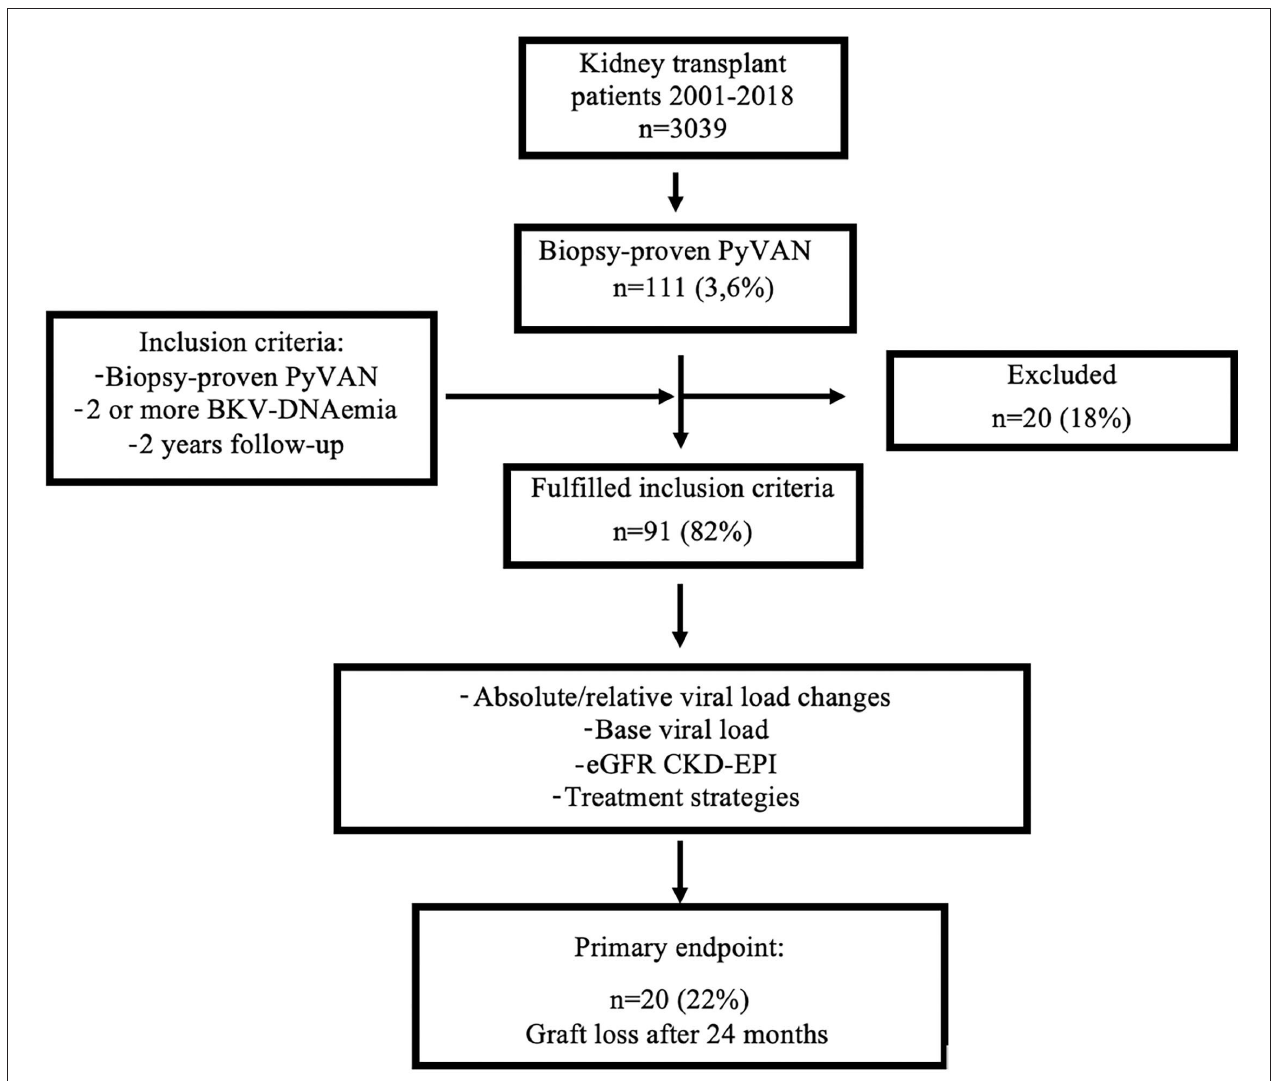
FIGURE 1 | Flowchart. Displays the flow-chart of the study; PyVAN, BK polyomavirus nephropathy; eGFR-CKD-EPI, estimated glomerular filtration rate measured by the CKD-EPI equation; BKV,